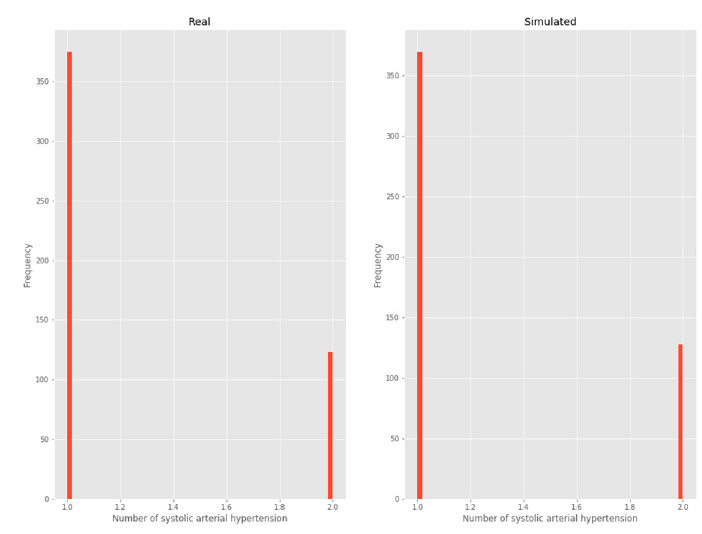
Figure 5. Systolic arterial hypertension.